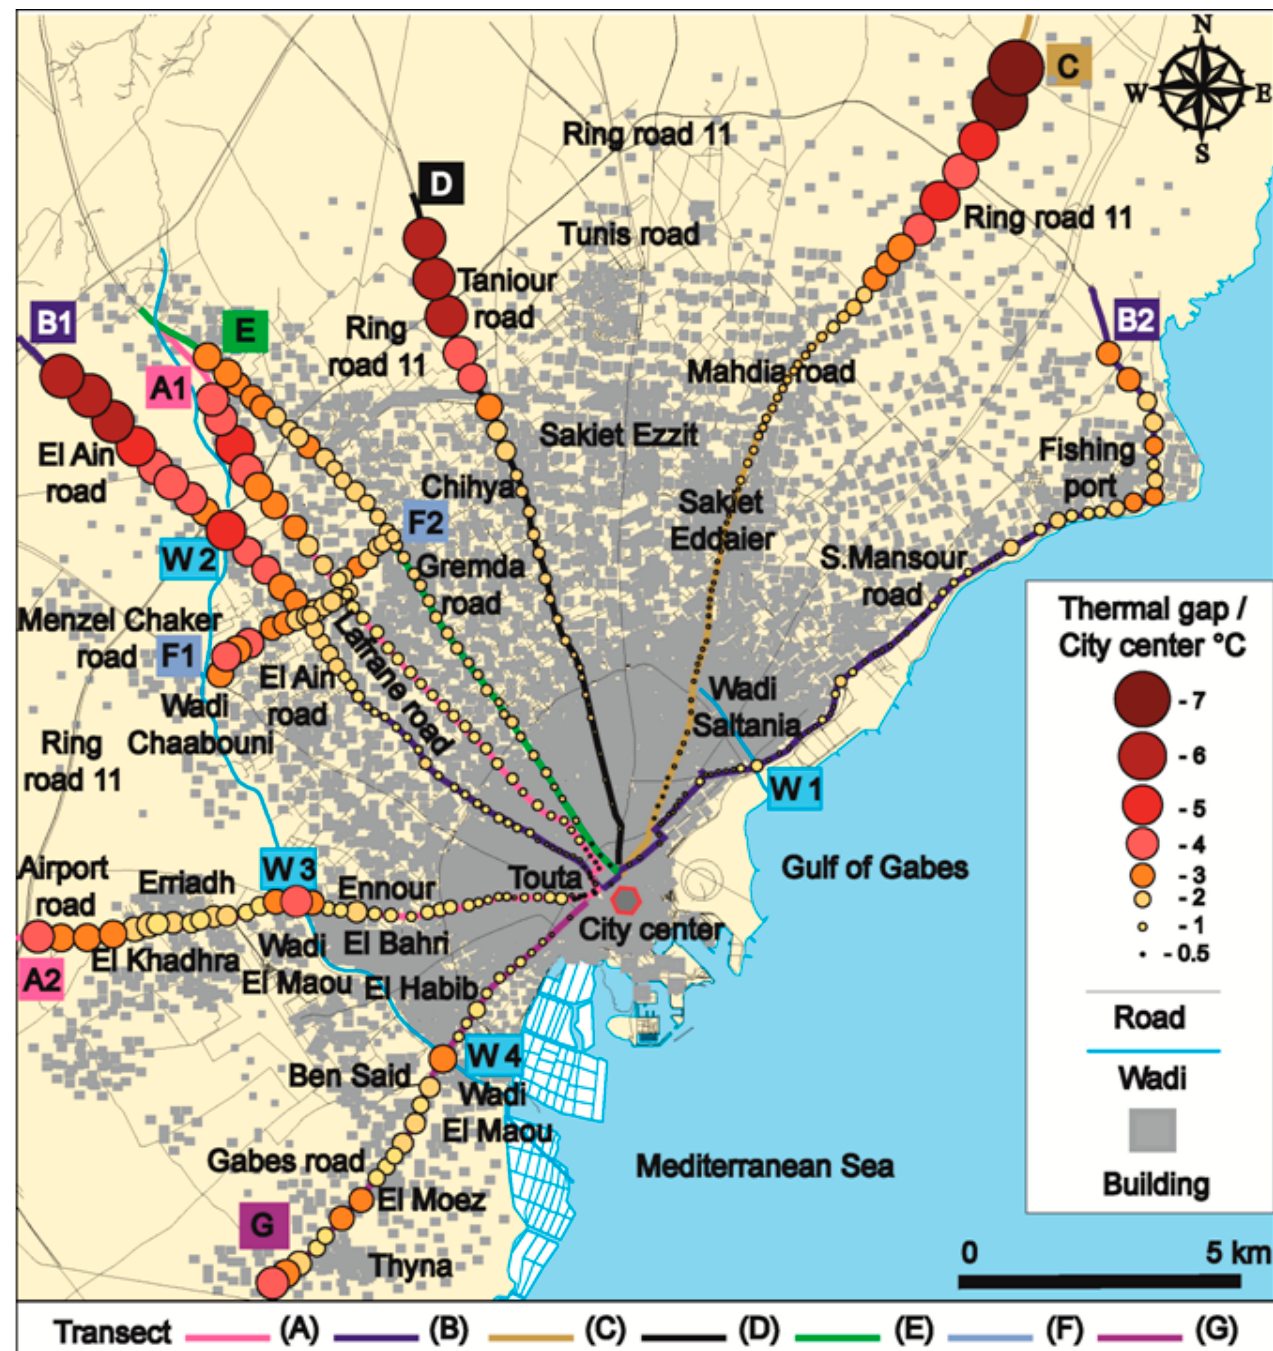
Figure 2. Spatial distribution of night air temperatures at 2 m above ground level (thermal gap with city center in °C) in the conurbation of Sfax according to the average temperature values calculated from 16 mobile survey campaigns at the level of the seven urban transects A, B, C, D, E, F and G.